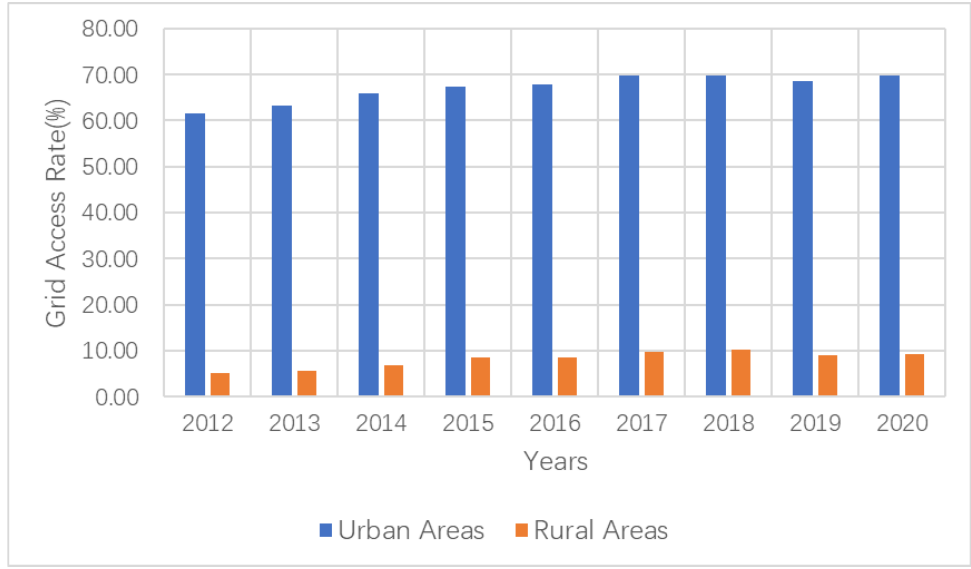
Figure 18. The grid access rates of the urban and rural areas in Rwanda from 2012 to 2020.